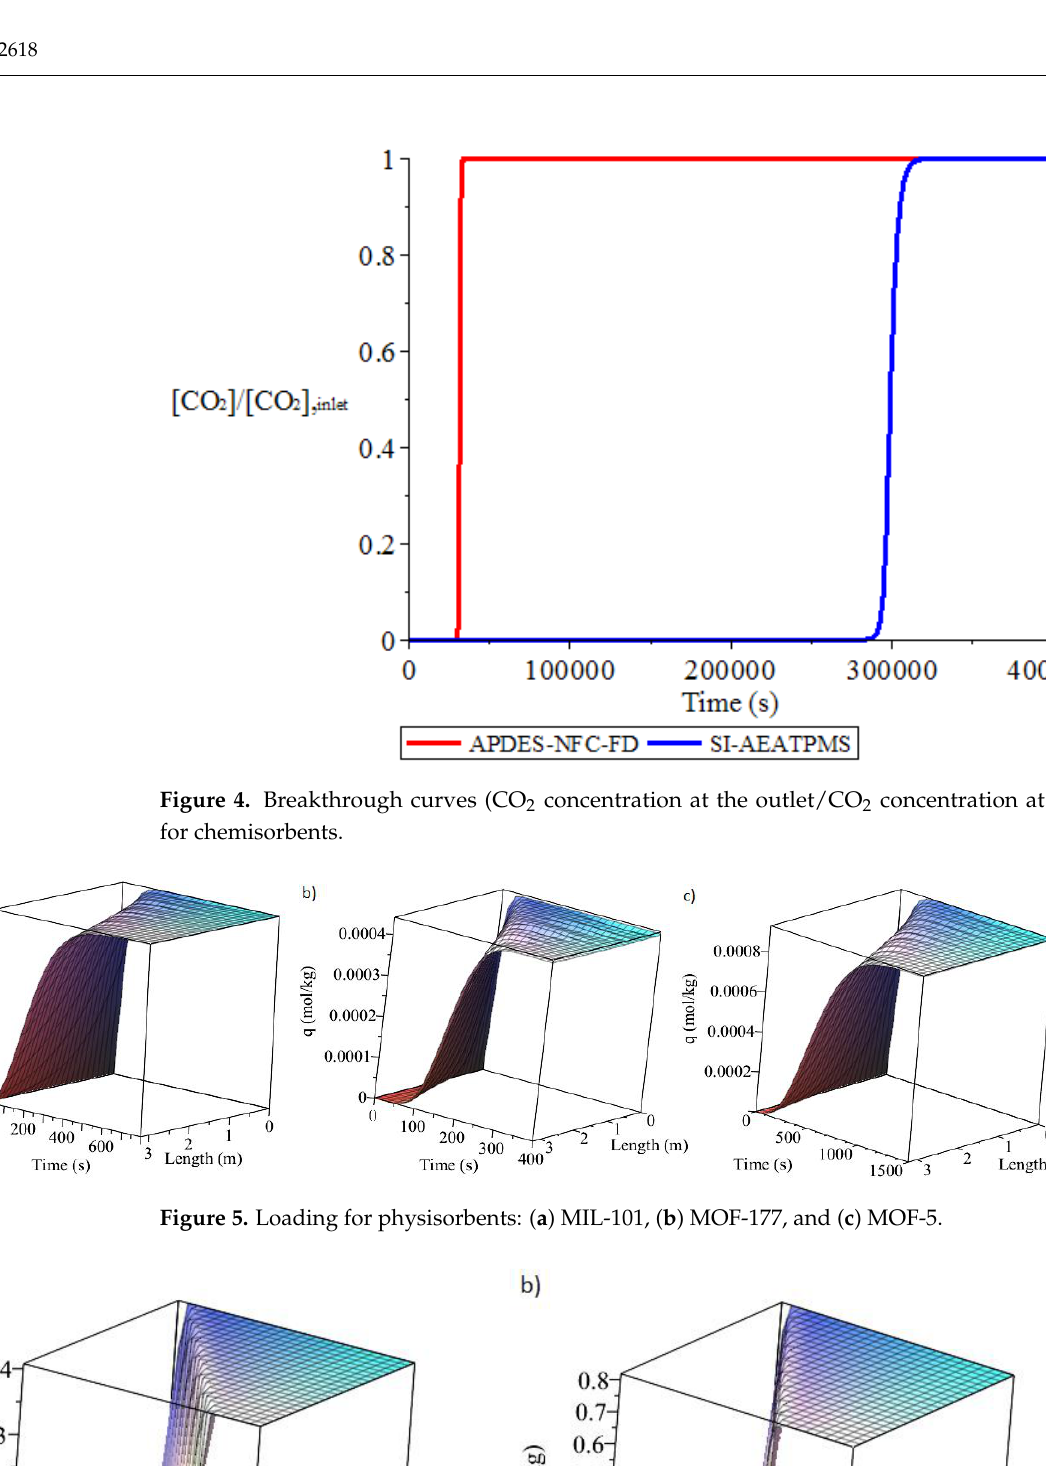
Figure 5. Loading for physisorbents: ( a ) MIL-101, ( b ) MOF-177, and ( c ) MOF-5 .